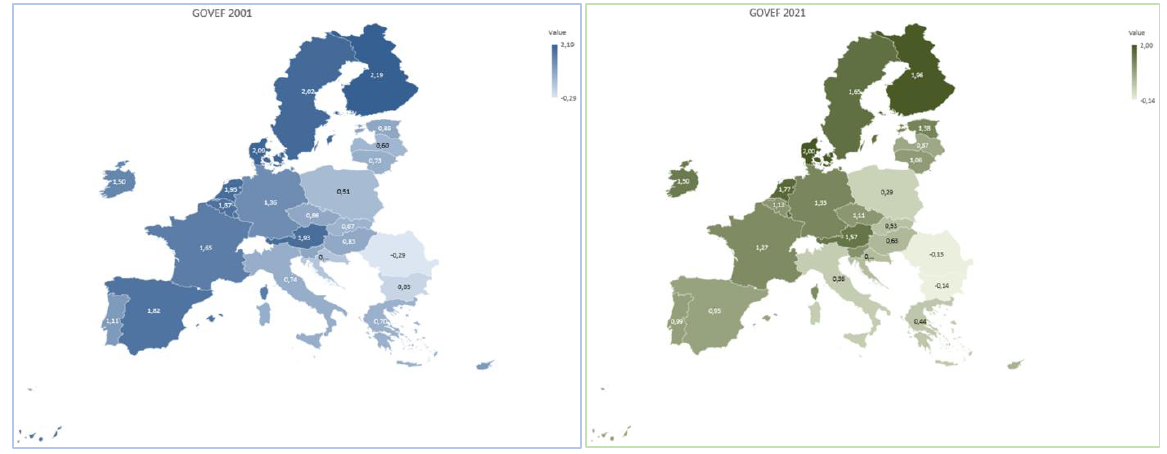
Figure 3. Government effectiveness evolution in the EU member states.